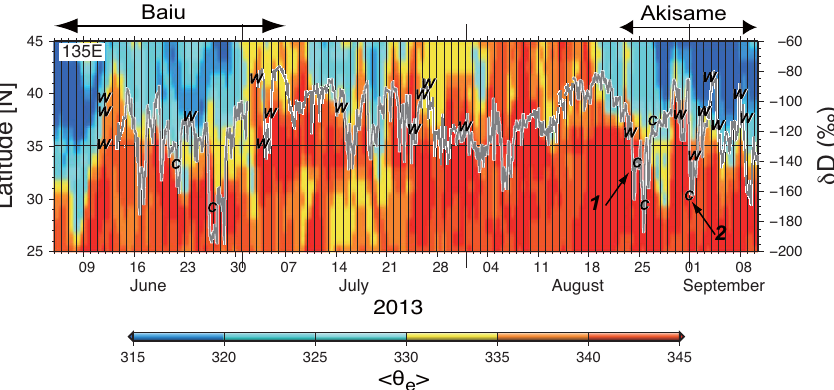
Figure 5. Time series of the value of δ D in surface vapor observed at Nagoya University (gray line) and vertically averaged (850–925hPa) equivalent potential temperatures (cid:104) θ e (cid:105) (K) between 25 ◦ N and 45 ◦ N along 135 ◦ E during summer (JJAS) in 2013. The labeled W’s (C’s) represent the value of δ D in surface vapor in equilibrium with warm (cold) type precipitation at the same